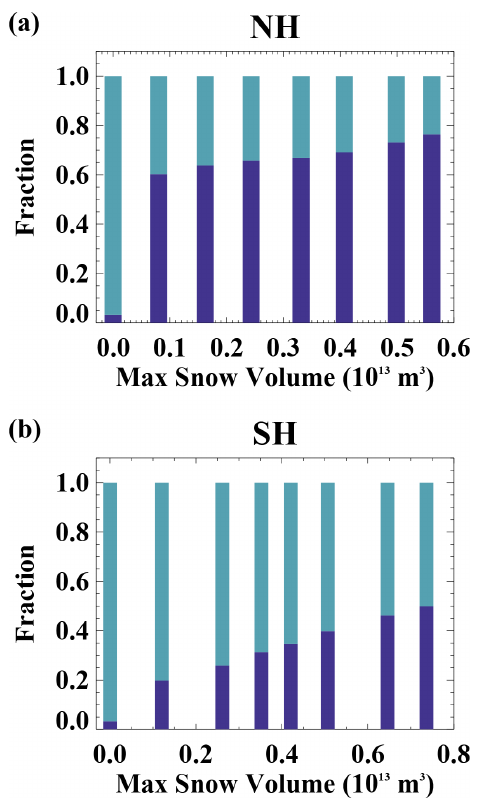
Figure 11. The fraction of the total ice area occupied by seasonal ice (light blue) and perennial ice (dark blue) as a function of the maximum snow volume across the experiments. Values are shown for the (a) Northern Hemisphere and (b) Southern Hemisphere.